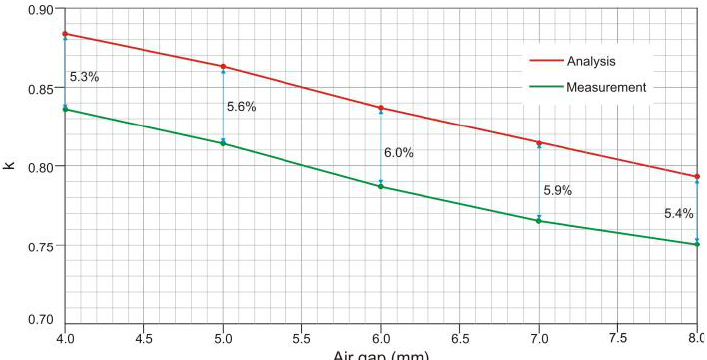
Figure 8. Coupling factor vs. air gap.